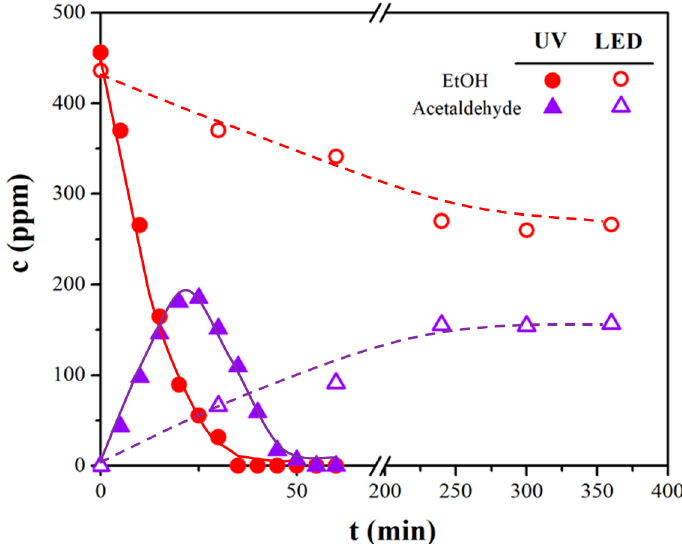
Figure 1. Ethanol disappearance and acetaldehyde formation in the case of Mn 20 1077_4 under both UV and LED sources.